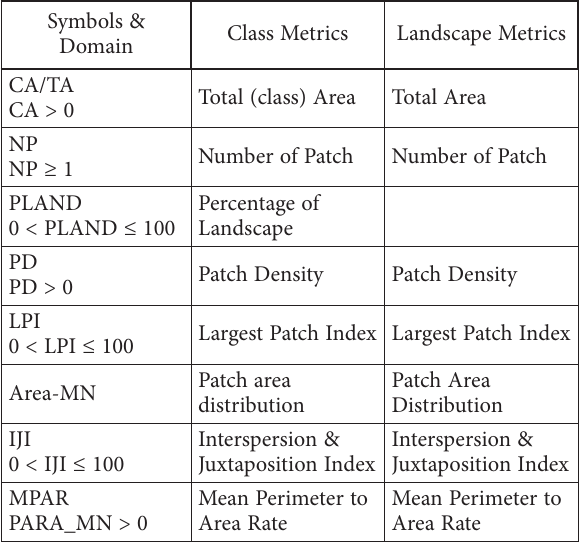
Table 2. Metrics utilized at the class and landscape levels Table 3. Mapping accuracy obtained by maximum likelihood